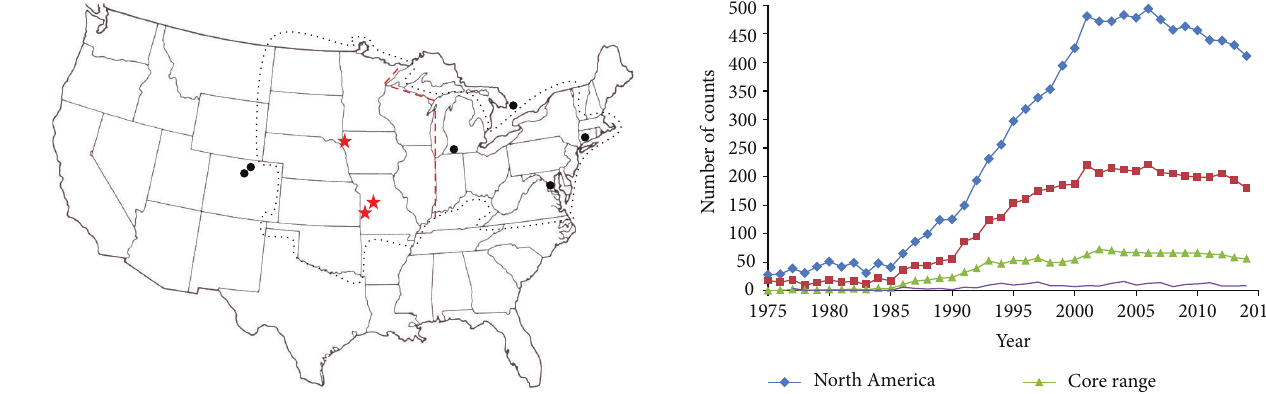
Figure3:MapshowingstatescontainingmainRegalFritillaryrange (encircled by black dotted line), core range (west of red dashed line), all count circles reporting Regal Fritillary outside core range (black circles), and the three count circles with highest Regal abundance (red stars).